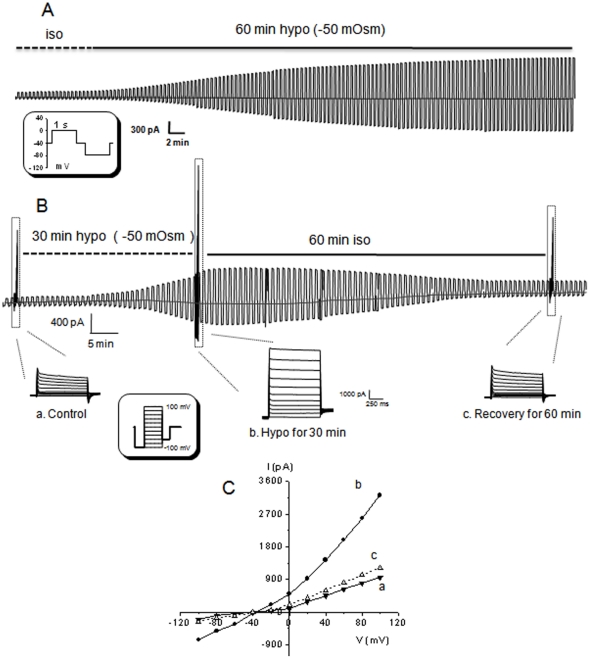
Expression of VRAC currents in CA1 pyramidal neurons in hippocampal slices.
A, Shows a hypoosmotic medium -activated -chloride conductance (HAC) from a pyramidal neuron. After initial recording in the isoosmotic medium (iso, dashed line) as control, the perfusion was switched to the hypoosmotic medium (hypo, −50 mOsm) for 60 min. The neuronal Na+, Ca2+ and K+ channel conductances were pharmacologically inhibited (see Methods). The cell was held at −40 mV in the resting condition, and a pair of alternate voltage pulses at ±40 mV was delivered to the cell every 15 second. Each test pulse in the pair was 1 second long and was separated from each other by 300 ms at −40 mV resting voltage (see the shadowed inset in A for protocol). Because each series of paired alternate pulses was delivered every 15 s, the time scale bar shown under A includes all the unrecorded time periods, or the duration of alternate pulses induced currents are not proportional to the applied time scale. A progressive increase of chloride conductance was recorded over a 60 min of hypo exposure. B. A whole-cell chloride conductance recording with 30 min of hypo exposure. The HAC slowly inactivated after switching the perfusion to the iso. In the same recording, a voltage step protocol was delivered to the cell at the times indicated as “a”, “b” and “c” that represent the chloride currents at control, HAC and recovery, respectively. The I-V curves in C were at times of “a” and “b” and constructed by plotting the steady-state currents against the applied voltages, ranging from −100 mV to +100 mV in a 20 mV increments (see shadowed inset in B). In all the I-V curves in C, the chloride conductance was outwardly rectifying and reversed at around −40 mV.